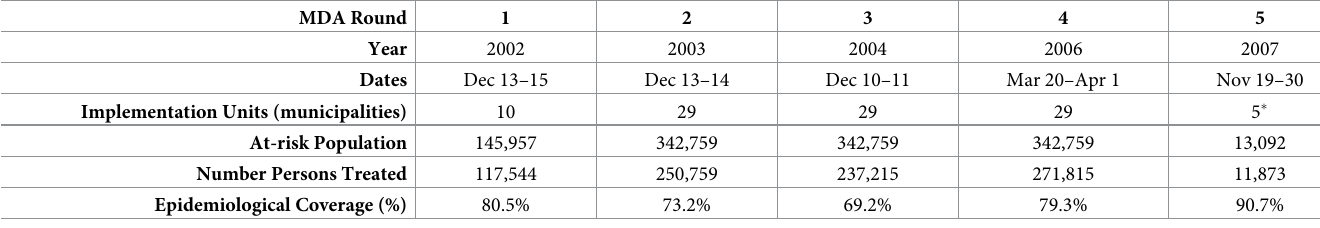
Table 1. Mass drug administration (MDA) for lymphatic filariasis in the Southwest